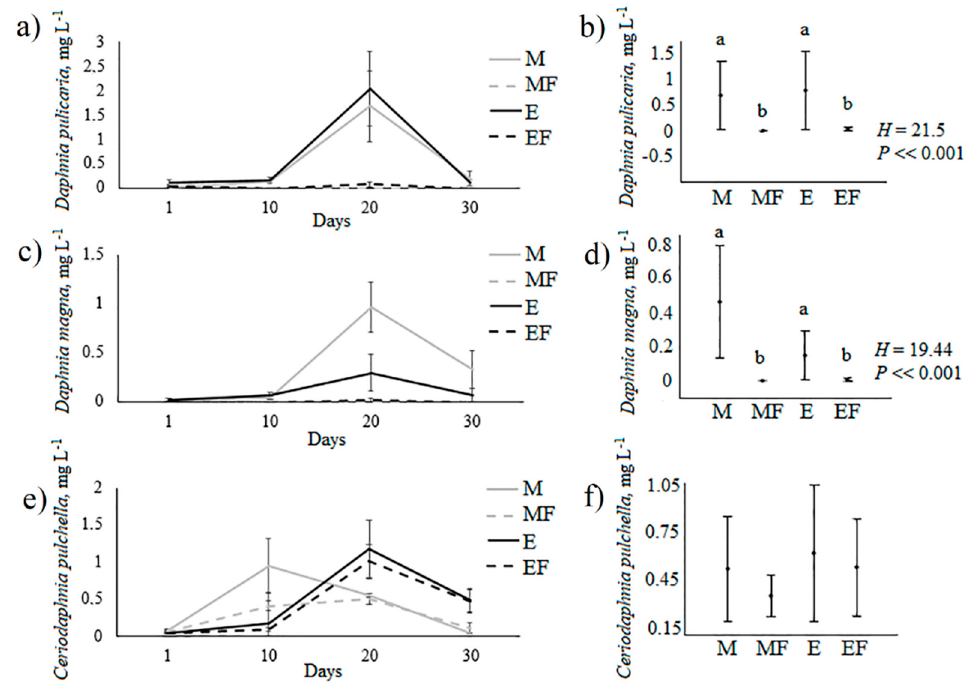
Figure 8. Dynamics of biomasses of D. magna , D. pulicaria , and C. pulchella in the experiment ( a , c , e ) and treatment means ( b , d , f ); di ff erent letters indicate significant di ff erences at P < 0.05 after Kruskal–Wallis test (H); M—mesotrophic conditions, MF—mesotrophic conditions with introduced fish, E—eutrophic conditions, EF—eutrophic conditions with introduced